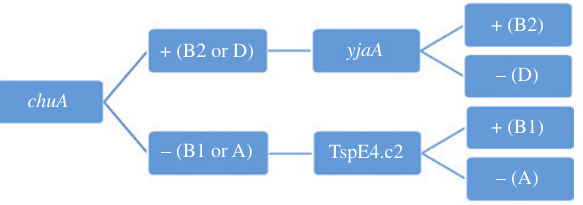
Figure 1: Assigning of different phylogenetic